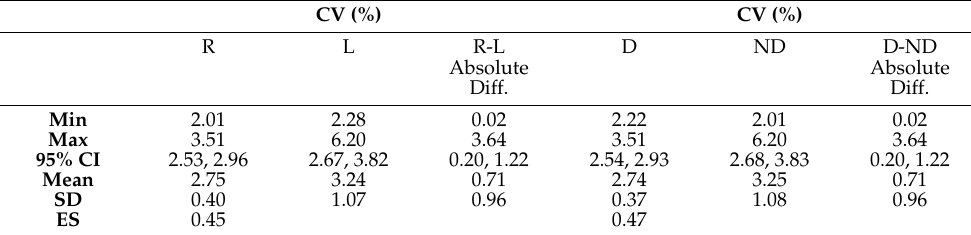
Table 1. Summary statistics and effect sizes for the coefficient of variation (n = 16).